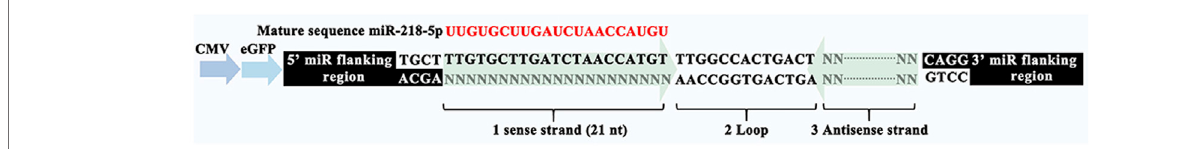
FIGURE 3 | Design and construction of miR-218-5p plasmid.